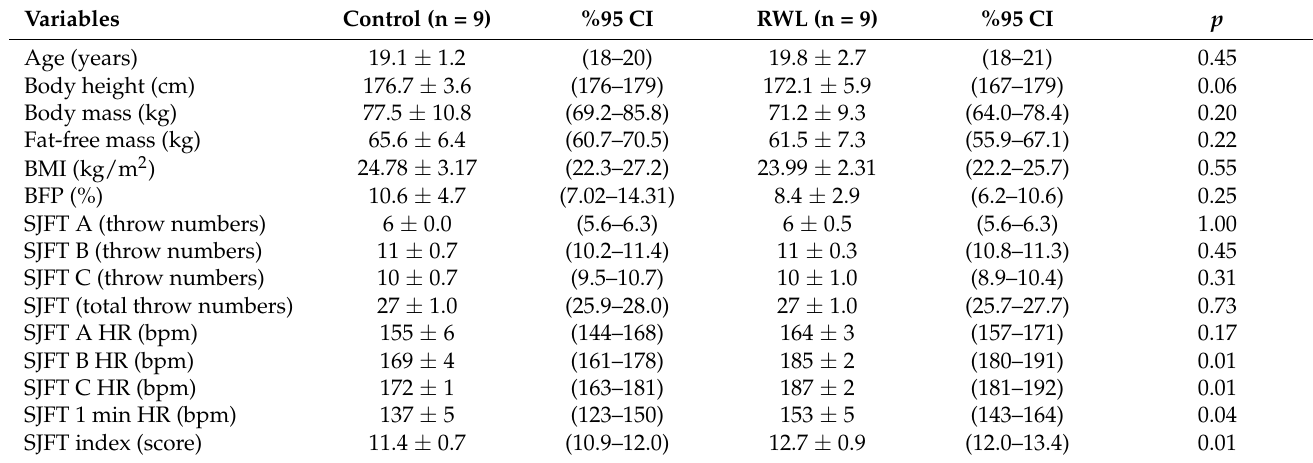
Table 1. Baseline characteristics and judo-specific performances of the